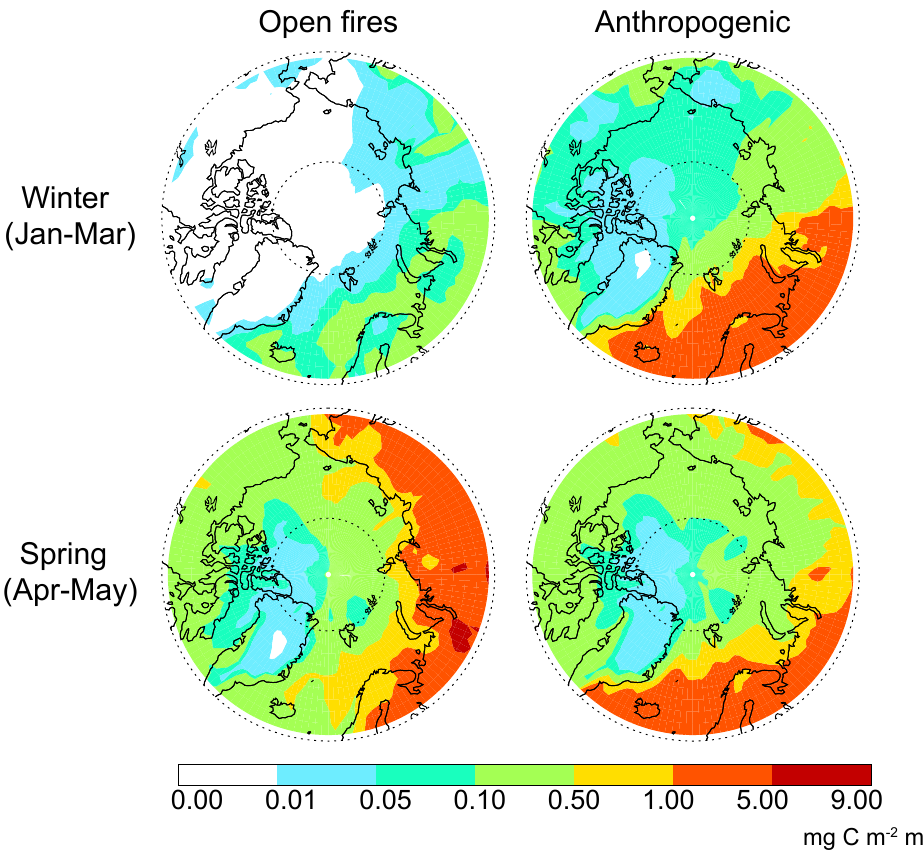
Fig. 11. Contributions of open fire and anthropogenic (fuel combustion) sources to the BC deposition flux in GEOS-Chem for winter and spring